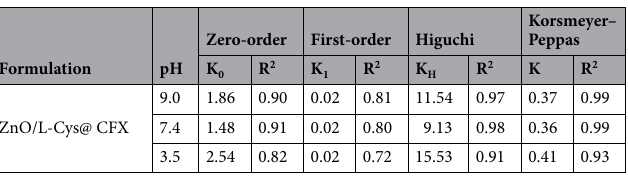
Table 1. The release rate constant (K) and regression coefficient (R 2 ) values of the different models.